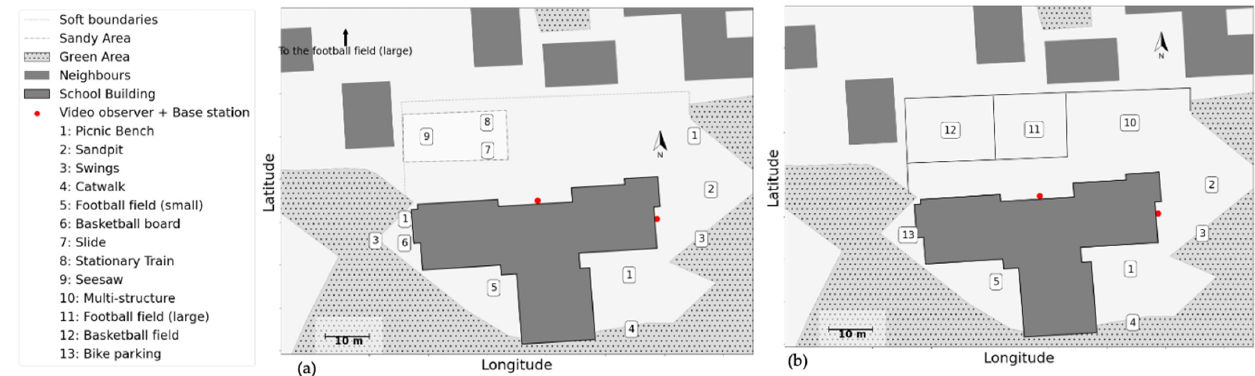
Figure 2. Layout of school B: a) before renovation, b) after renovation.